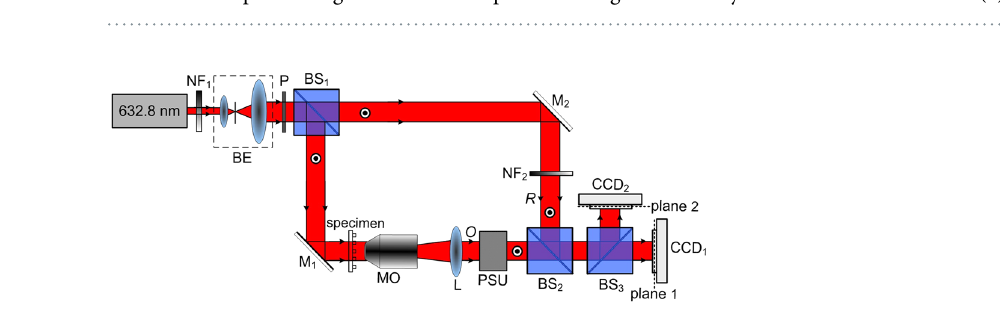
Figure 5. TPD-DH imaging of the living HeLa cells. ( a ) Reconstructed amplitude image of the cells; ( b ) Reconstructed phase image of the cells. All pictures in Fig. 5 are exactly the same size. Scale bar in ( a ), 100 μ m.